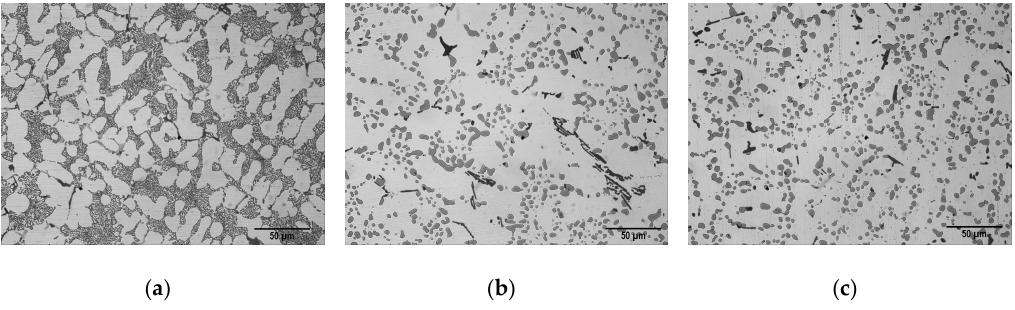
Figure 2. Microstructure of the material obtained by optical microscopy (OM). ( a ) as-cast state; ( b ) following a solution treatment at 525 °C for 4 h; ( c ) following a solution treatment at 525 °C for 10 h.